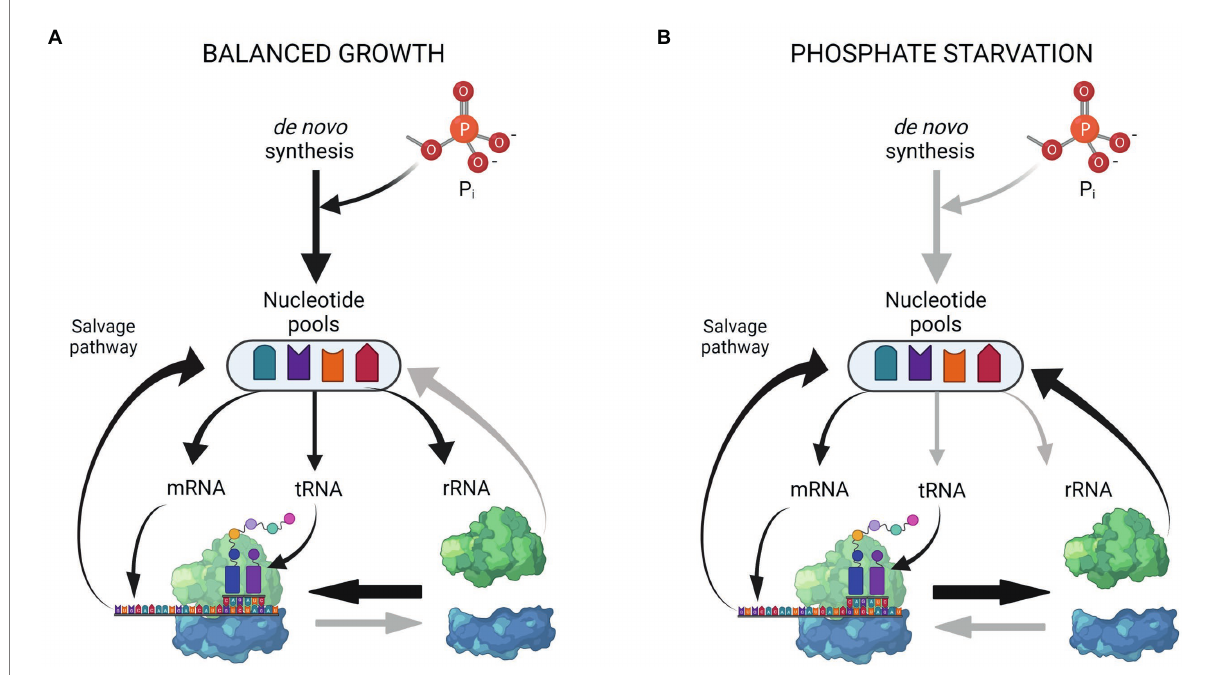
FIGURE 6 Coarse model of RNA pool redistribution upon P starvation. (A) During steady-state growth, the nucleotide pools are maintained by de novo synthesis and nucleotide recycling from mRNA turnover. Most ribosomes are engaged in translation. (B) During starvation, no extracellular P is available for de novo synthesis. RNA synthesis is decreased and focused on mRNAs of the Pho regulon. Reduced protein synthesis leads to more vacant ribosomes, which makes the RNA in the free ribosomal subunits susceptible to degradation. Nucleotides for continued mRNA synthesis are provided from rRNA degradation and mRNA turnover. The figure was created with